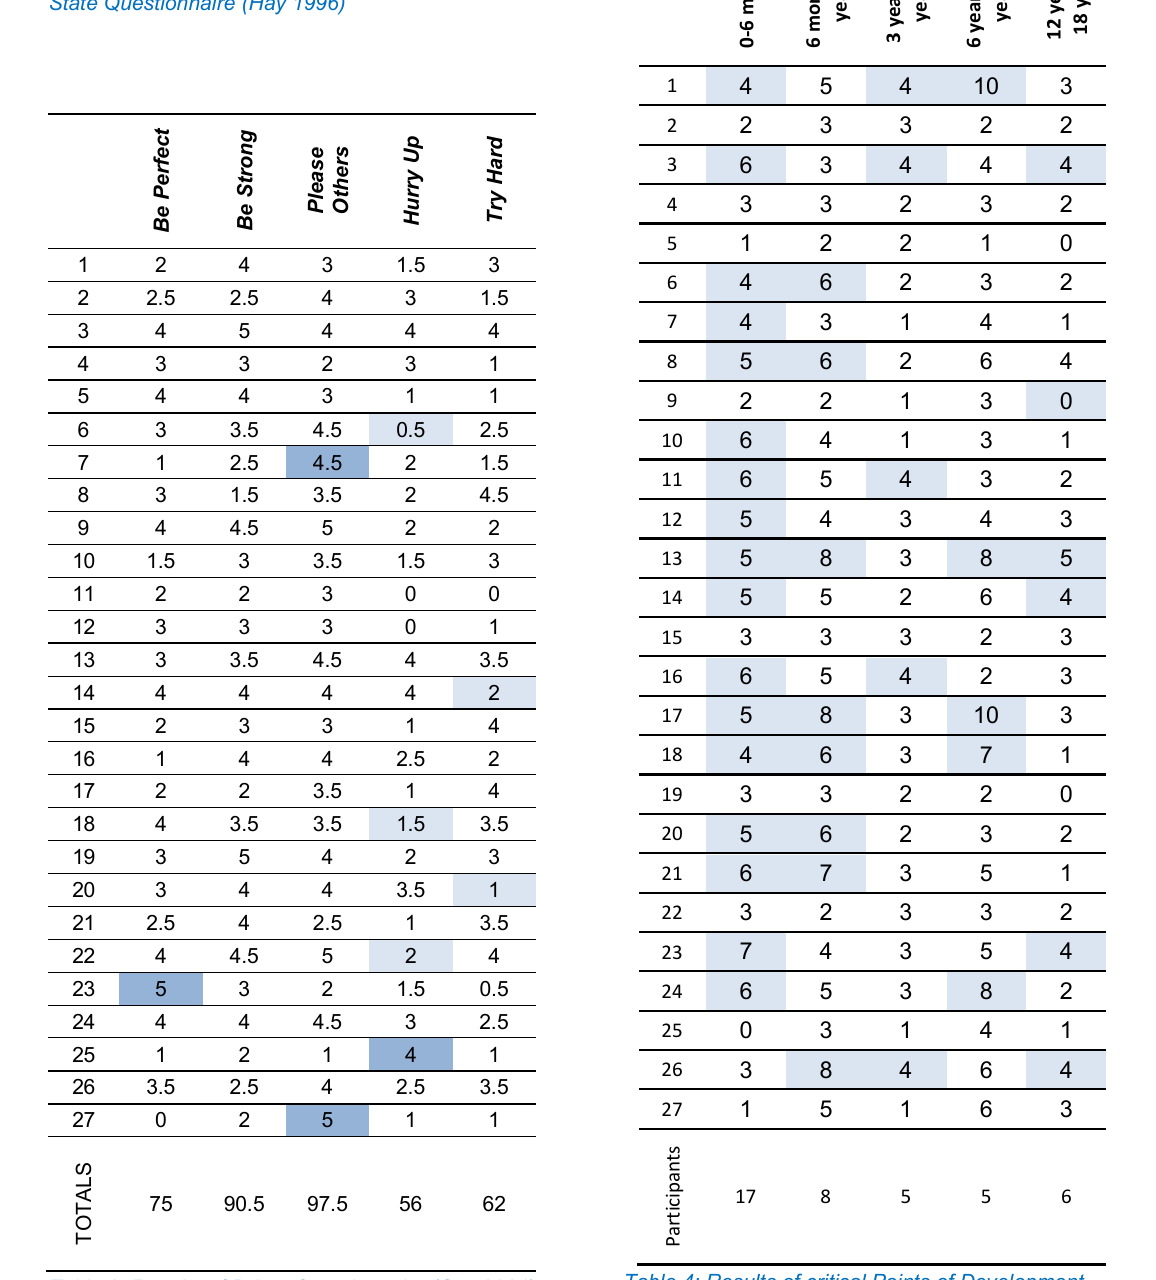
Table 3: Results of Driver Questionnaire (Cox 2001) Table 4: Results of critical Points of